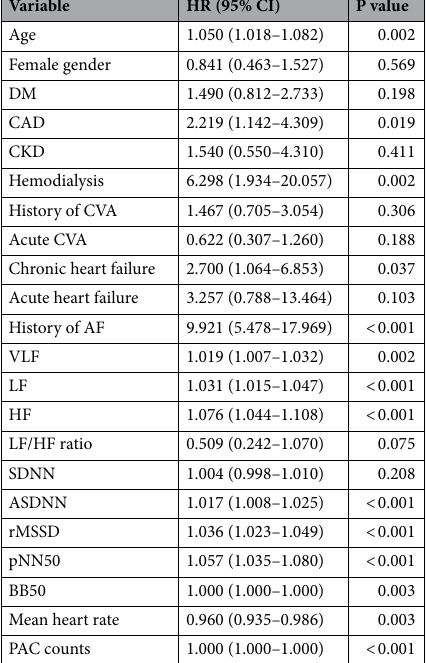
Table 4. Univariate analysis of the occurrence of atrial fibrillation. DM, diabetes mellitus; CKD, chronic kidney disease; CAD, coronary artery disease; CVA, cerebrovascular accident; VLF, very low frequency; LF, low frequency; HF, high frequency; SDNN, standard deviation of the NN interval; ASDNN, average standard deviation of all 5-min RR intervals; rMSSD, square root of the mean squared differences of successive NN interval; pNN50, the percentage of RR intervals that are more than 50 ms different from the previous interval; BB50, the count of intervals that are more than 50 ms different from the previous